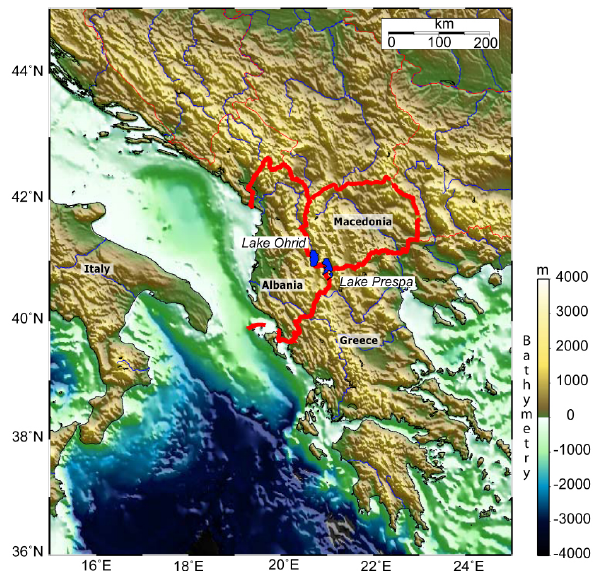
Fig. 1. Map of southern Europe with Lake Ohrid and its sister Lake Prespa located on the Balkan Peninsula.